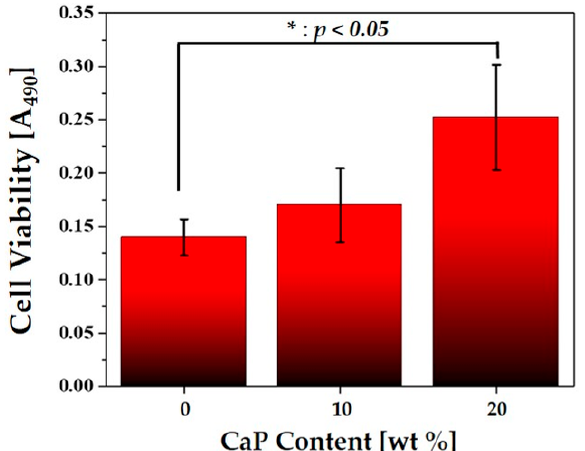
Figure 10. Cell viability of the MC3T3-E1 cells cultured for 5 days on the macro/micro-porous PCL–CaP composite scaffolds produced with various CaP contents (0, 10, and 20 wt%).